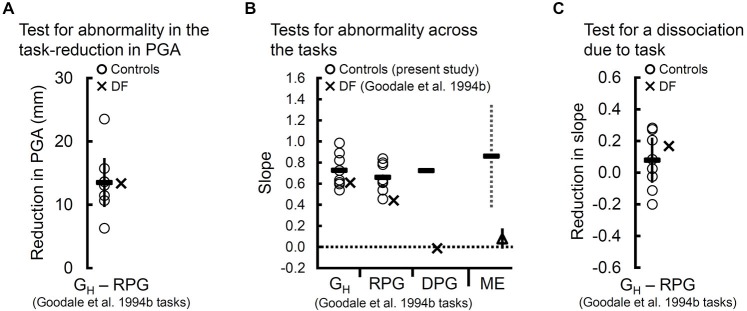
Tests for dissociation using peak grip aperture (PGA) and the slopes of the controls (“O”s) and of DF (“X”s) across the natural grasps with haptic feedback (GH) and “real-time” pantomimed grasps (RPG) and tests for abnormality in DF’s slope across the GH and RPG tasks. (A) Reduction in PGA between the GH and RPG tasks. The solid vertical bar reflects the 95% confidence interval and indicates a significant reduction in PGA moving from GH to RPG for the controls. As can be seen, DF showed a similar reduction in her overall PGA. (B) Slopes relating PGA to target size for the controls (“O”s) and for DF (“X”s) for the GH and RPG tasks. Dashes indicate the mean slope for the controls. DF’s slopes differ significantly from zero and are within the normal range in both tasks. For illustration, we included (1) the mean slope for the controls (solid dash) along with DF’s slope (“X”) computed from data reported by Goodale et al. (1994b) for the delayed-pantomimed grasping task (DPG); and (2) the mean slope relating grip aperture to Efron block width for DF (open triangle) and for the controls (solid dash) across 4 studies (Goodale et al., 1991; Westwood et al., 2002; Whitwell et al., 2014a, in press) of DF’s manual (perceptual) estimates (ME) of Efron block width. Evidently, the DPG task has a far more detrimental impact on DF’s slope than does the RPG task. In fact, DF’s slope in the DPG task failed to differ from zero (p = 0.9). Interestingly, DF’s particularly poor slope for the DPG task resembles those that are typically observed when she performs ME task. A 95% confidence interval around the controls’ mean ME slopes can be used to compare DF’s mean ME slope across those same four studies. Clearly, DF’s mean ME slope falls well outside the normal range. A 95% confidence interval to compare her mean ME slope against zero failed to yield a significant difference (p = 0.09). (C) The controls slopes for the GH and RPG tasks do not differ significantly and, critically, the difference in DF’s slope between the two tasks falls within the range of differences observed in the controls. Thus, when compared to the GH task, the RPG task affected DF’s slopes no differently than it did the controls.